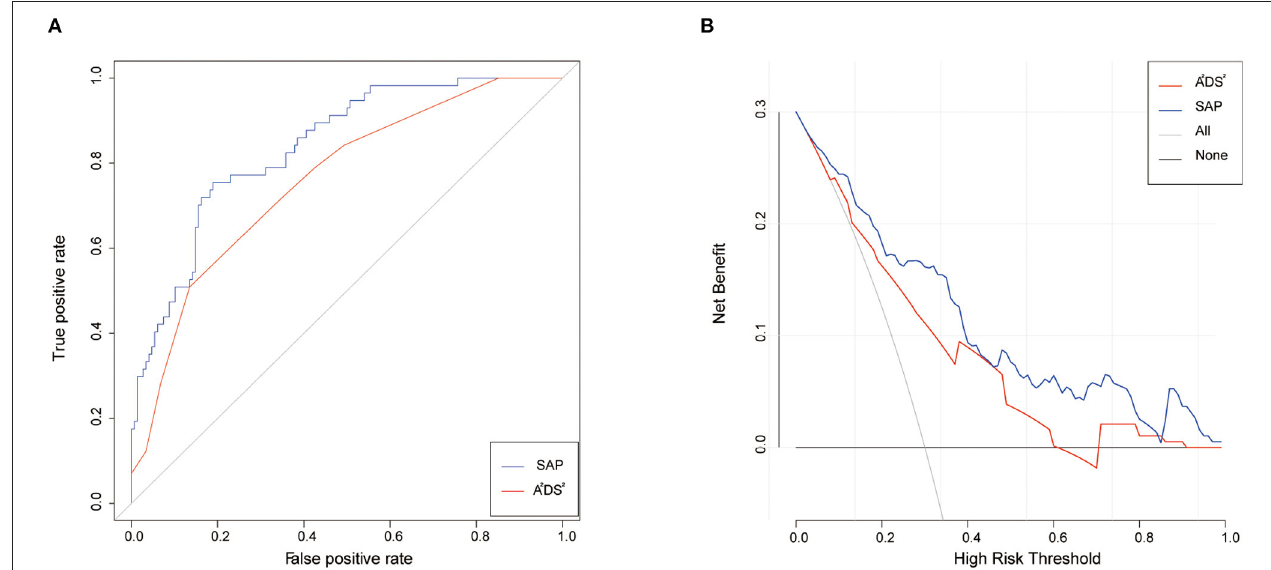
FIGURE 6 | Receiver-operating characteristic analysis and decision curve analysis for the A 2 DS 2 and SAP model to the prediction of SAP. (A) the C-statistics for the A 2 DS 2 (red line) and SAP model (blue line) in the data. (B) The y-axis measures the net benefit. The red line represents the A 2 DS 2 . The blue line represents the SAP model. The gray line represents the assumption that all patients have SAP. The black line represents the assumption that no patients have SAP. SAP, stroke-associated pneumonia.